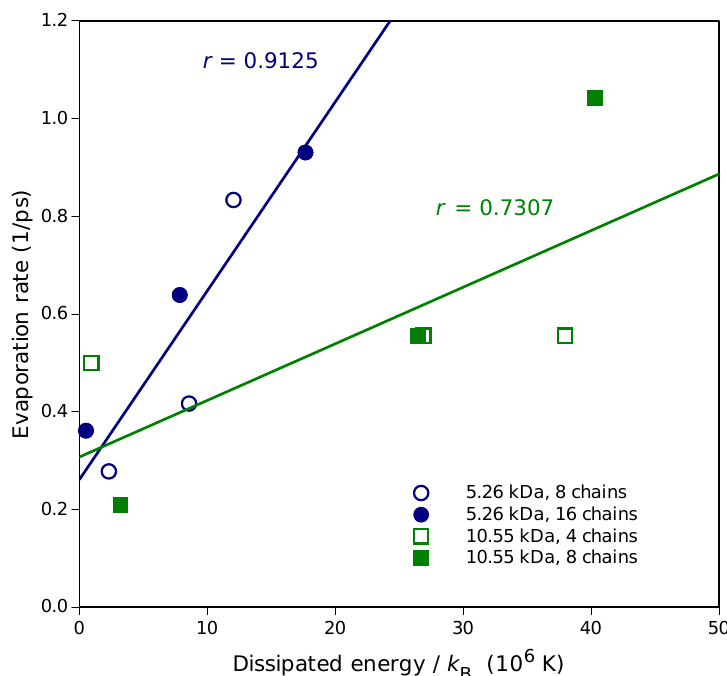
Figure 26. The solvent evaporation rate vs the dissipated energy divided by k B for 0–72 ps of production time. Simulation data (symbols) are shown along with a linear least-square regression (line). Pearson’s correlation coefficients, r , are also displayed alongside the regression lines. Results for 8 or 16 5.26-kDa PEG chains (open or filled blue circles), and for 4 or 8 10.55-kDa PEG chains (open or filled green squares) are shown. Plotted by Gnumeric [57] and edited with Inkscape [14].